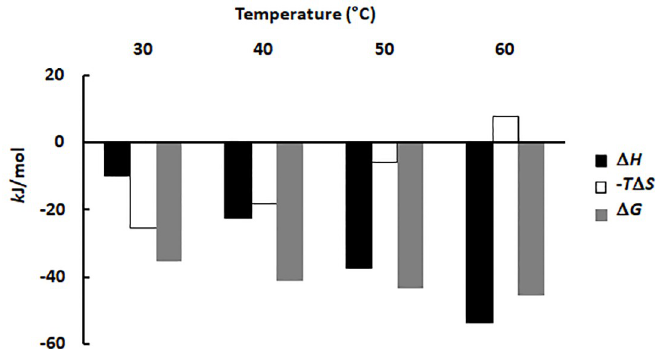
Fig 6. Thermodynamic parameters of the HisF and HisH binding calculated from the ITC experiments at different temperatures.